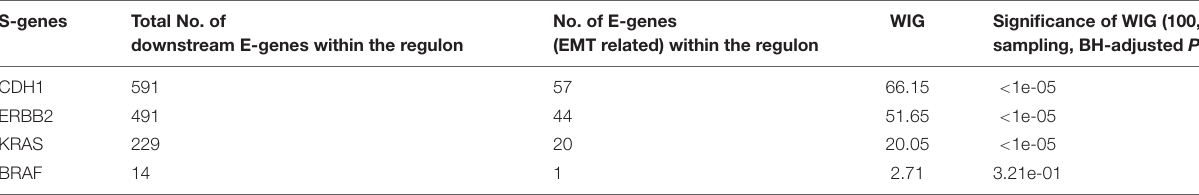
No. of E-genes (EMT related) within the regulon